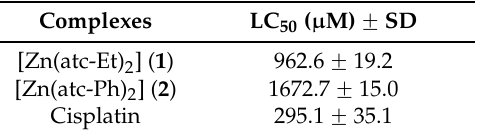
Table 3. LC 50 of zinc complexes 1 and 2 and cisplatin in Artemia salina L.